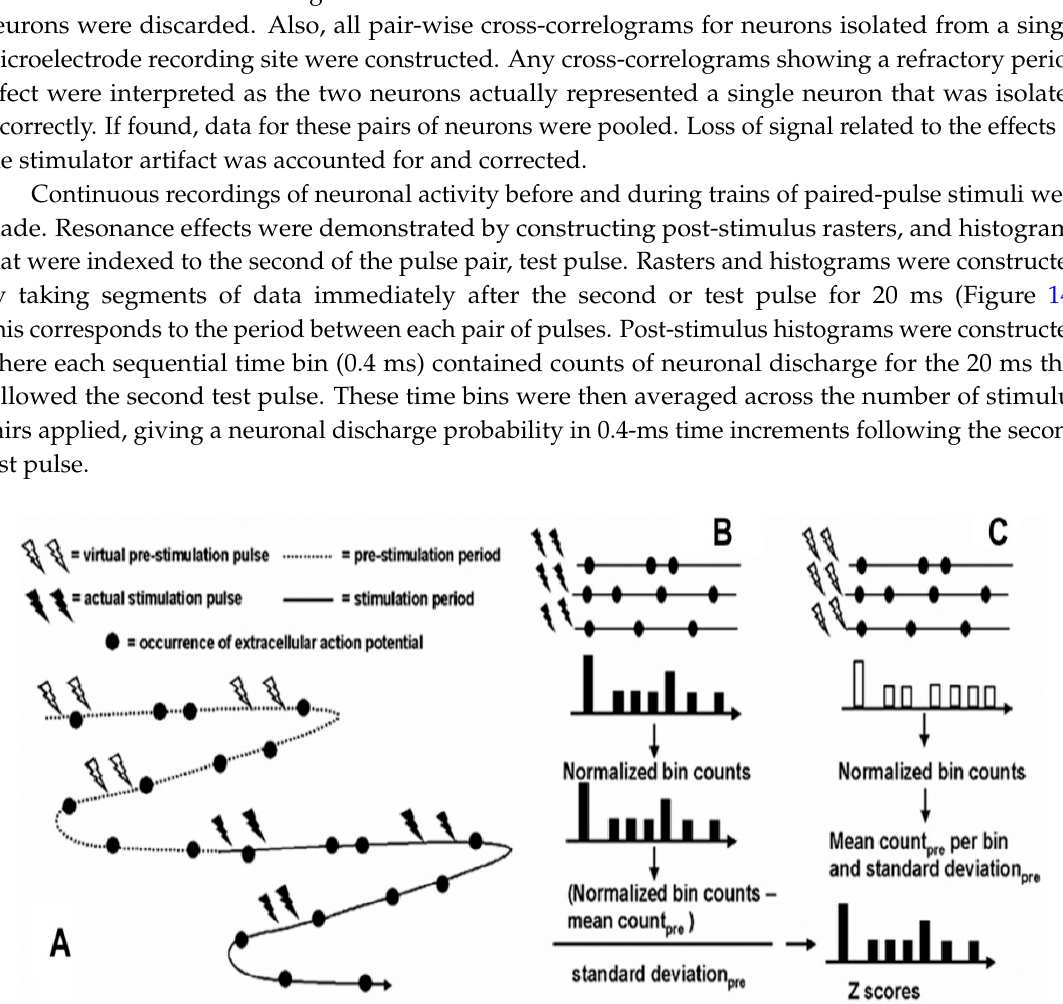
Figure 14. Schematic representation of analysis methods for detecting a resonance effect for paired-pulse stimulation. A set of virtual stimulus pulse pairs was created during the prestimulation period by translating the timing of the actual stimulation pulse pairs into the prestimulation period ( A ). Post-stimulus rasters and histograms were constructed indexed to the second pulse of the actual ( B ) and virtual ( C ) stimulation pulses. The rasters were collapsed across rows into the time bins (0.4 ms) of the histograms, resulting in counts of extracellular action potentials. This was normalized by dividing by the number of sets of paired pulse stimuli, resulting in probabilities of neuronal discharge in each time interval following the second stimulus pair. The mean probabilities per bin and the standard deviation were calculated for the virtual stimulation histograms ( C ). The mean was then subtracted from each time bin probability during the actual stimulation and divided by the standard deviation, resulting in a z score ( B ).